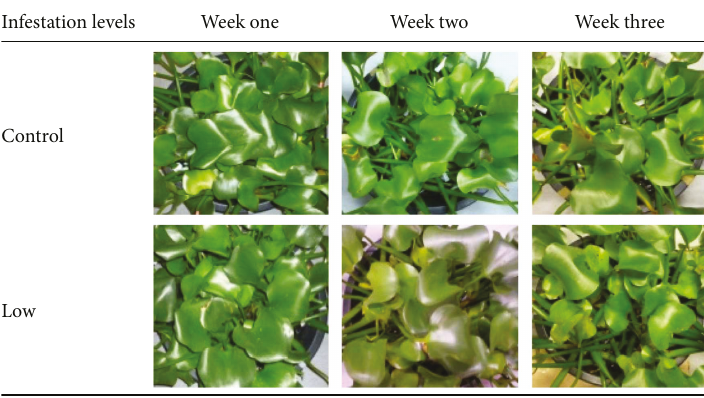
Figure 2: Photographs of healthy and low infested water hyacinth ( E. crassipes ) plants over three weeks of infestation (Adapted from Agjee et al .